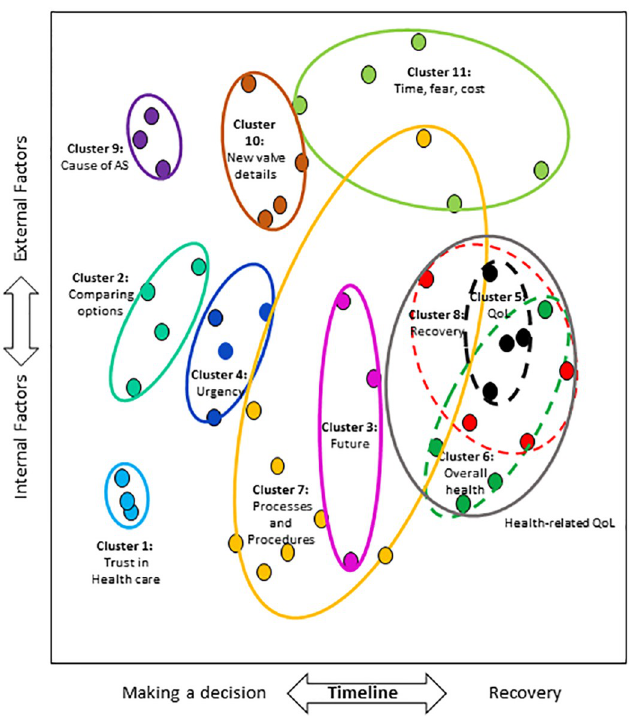
Fig 3. Cognitive map of patient treatment features. Each cluster identifies how the specific treatment features identified using the nominal group technique were grouped and labeled by 36 patients during card sorting activities. Multidimensional scaling defined the spatial orientation of each specific feature, hierarchical cluster analysis guided the identification of clusters. QoL denotes quality of